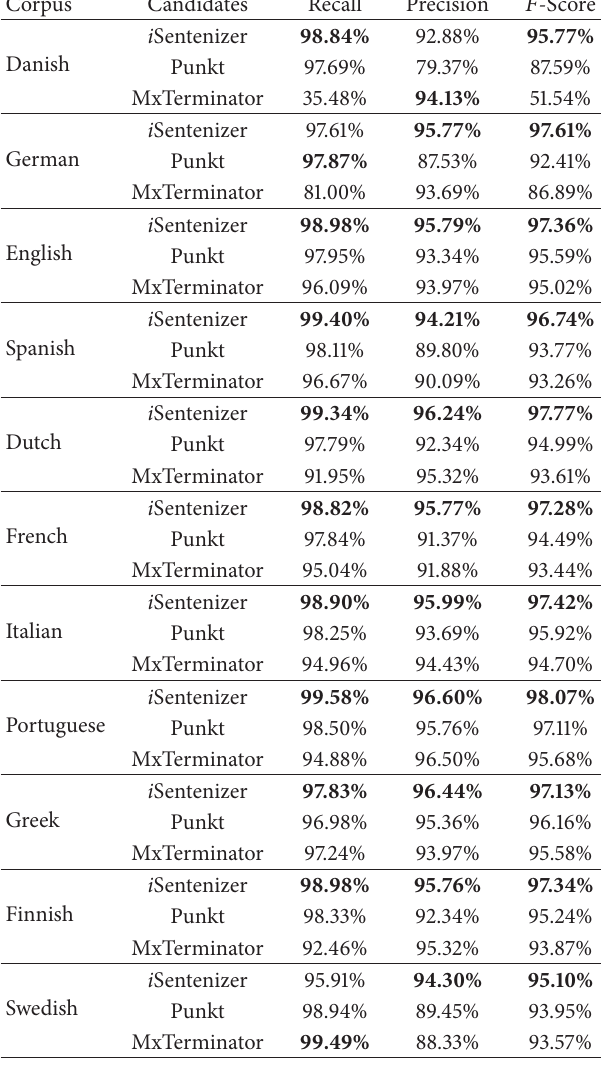
Table 4: Size of the Brown, WSJ, and Tycho Brahe corpora. Corpus